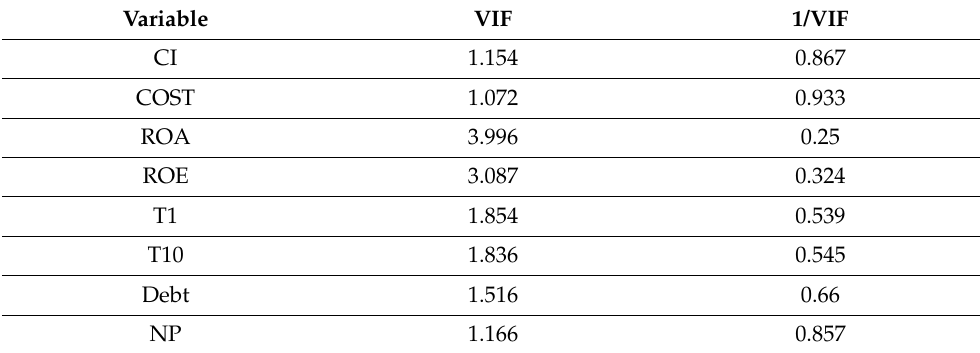
Table 2. Multicollinearity